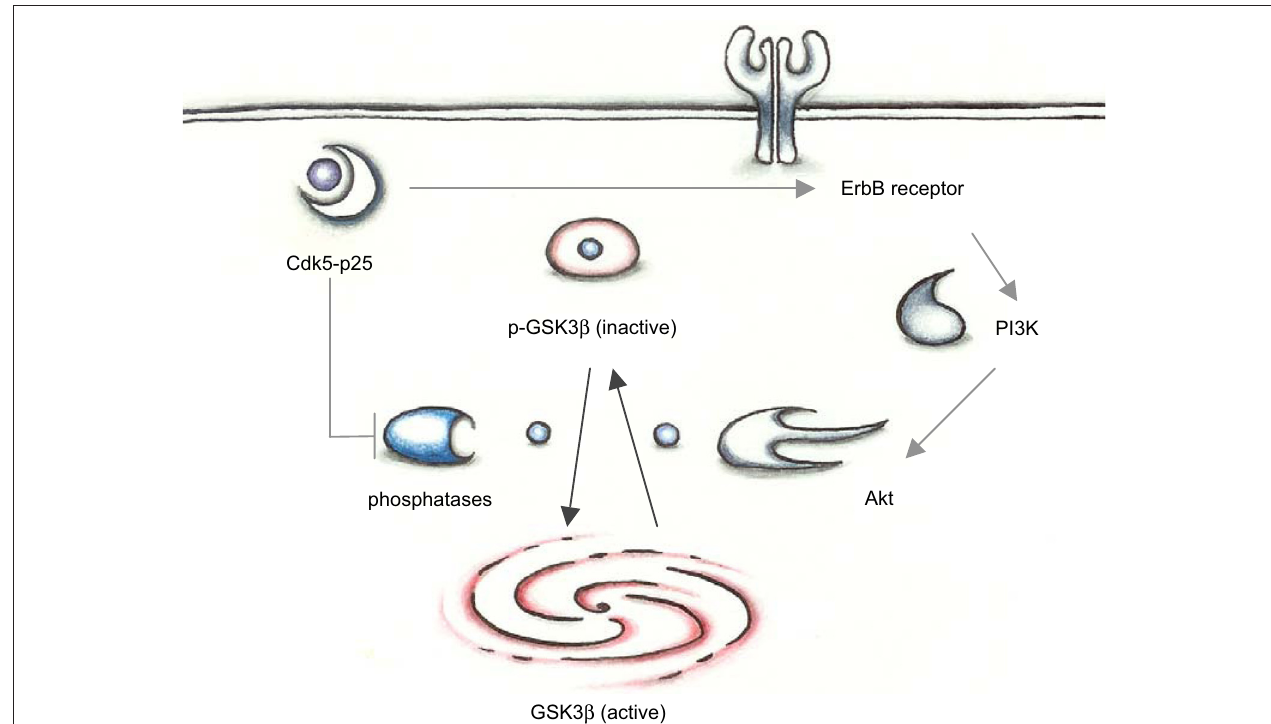
FIGURE 1 | In young mutant mice with low p25 expression, GSK3 β is inhibited by phosphorylation at Ser 9. Cdk5-p25 may infl uence the balance between p-GSK3 and an activatory dephosphorylation via regulation of phosphatases and the PI3K/Akt